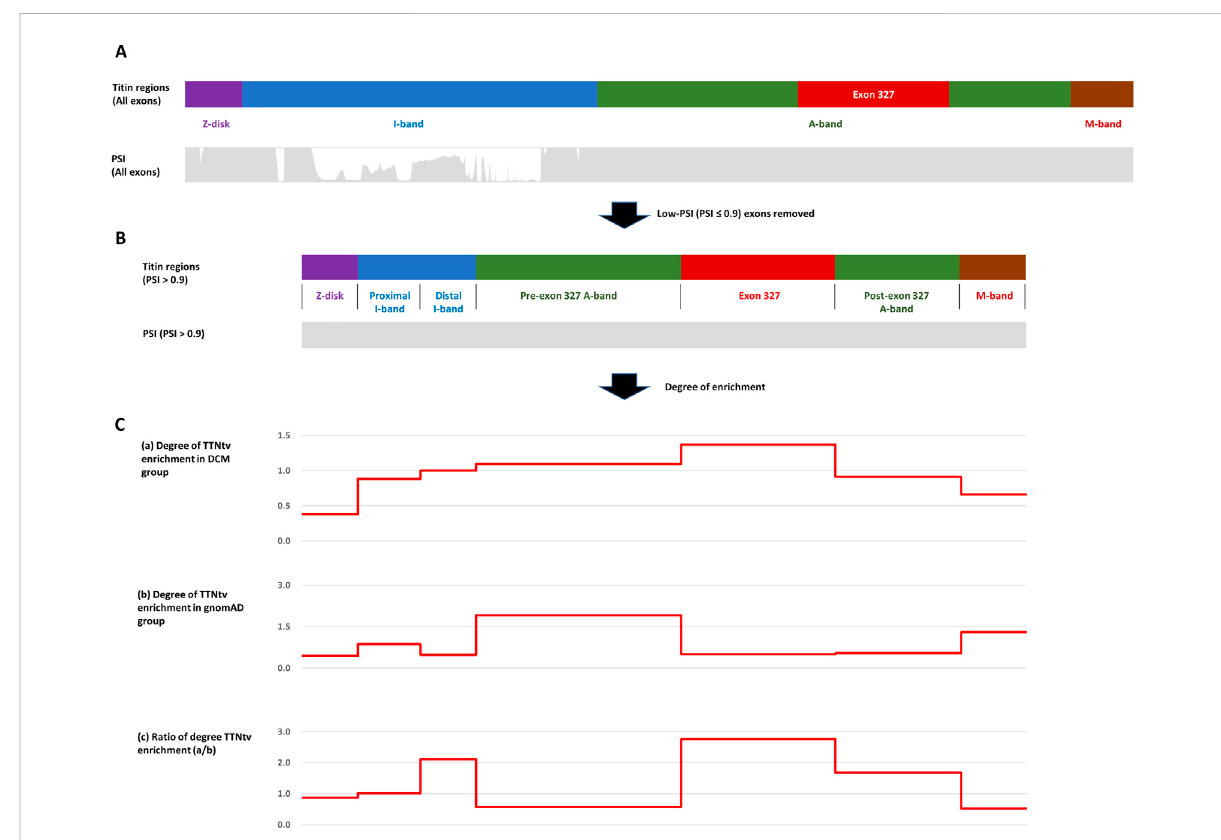
FIGURE 1 (A) Four regions of titin meta-transcript (NM_001267550.2) with PSI (Percent spliced-in) distribution. (B) After low-PSI exons were removed, I-band was divided into two sub-regions (Proximal I-band: exon 29 – 50, Distal I-band: exon 220 – 252), and A-band was divided into three sub- regions (Pre-exon 327: exon 253 – 326, exon 327, post-exon 327: exon 328 – 358). (C) Degree of Titin-truncating variant (TTNtv) enrichment calculatedbasedontheratioofobservedandexpected(basedonthelengthoftheregion)numberofTTNtv. (A) DCMgroup (B)